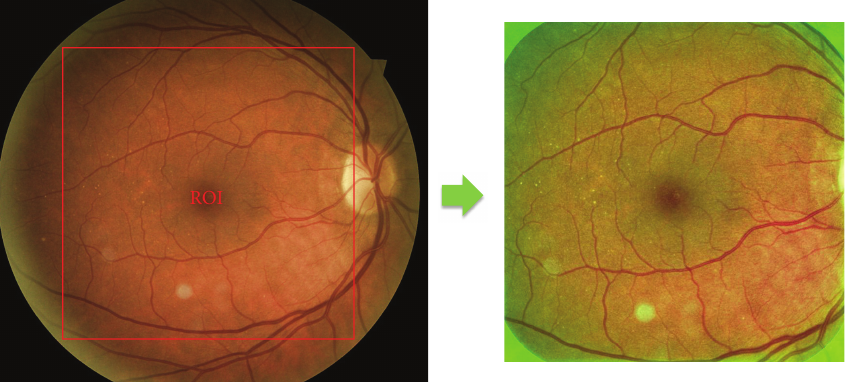
Figure 2: Preprocessing method: ROI corresponding to the square inscribed in the circle formed by the retina and the result of preprocessing with illumination normalization and contrast enhancement in green